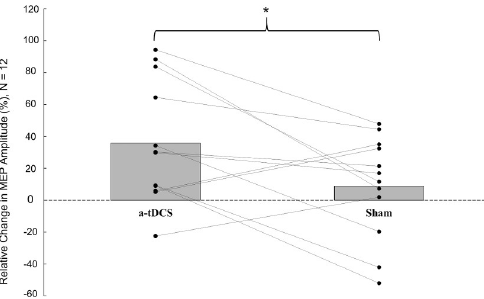
Fig 2. Relative change in peak-to-peak amplitude of motor evoked potentials from pre test to post test during the a-tDCS and sham stimulation protocol. Grey bars represent the group average. Black circles represent individual participants. � denotes significant difference ( P < 0.05). N =